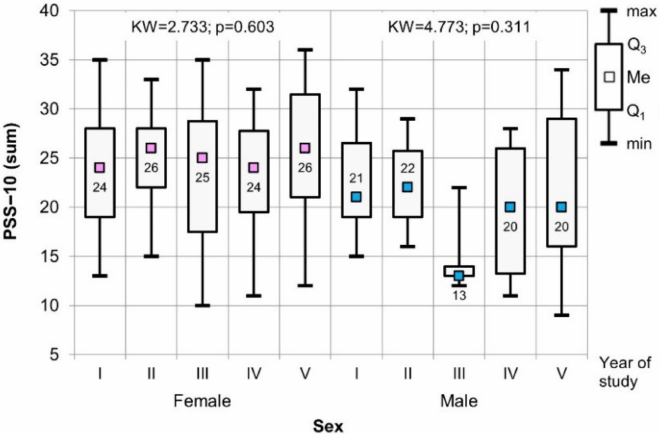
Figure 3. Results of the Kruskal–Wallis test used to assess the significance of difference values for the PSS-10 (sum) scale in relation to gender of respondents and year of